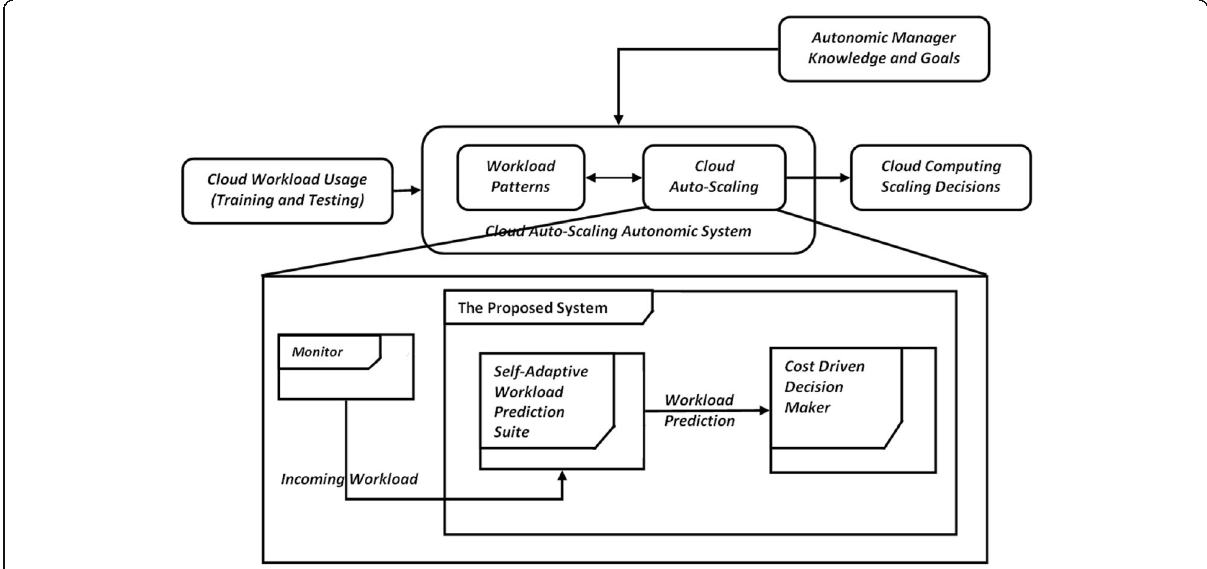
Fig. 3 Projection of the cloud auto-scaling autonomic